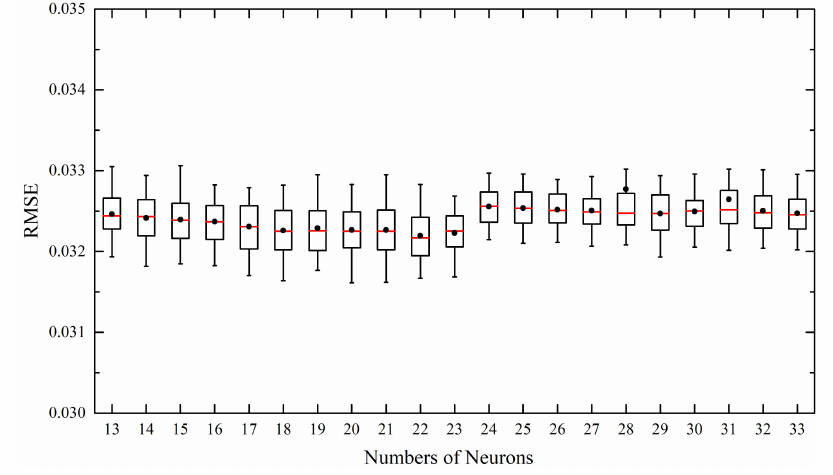
Figure 4. Prediction RMSEs for different total numbers of neurons with a single hidden layer (neural network model for